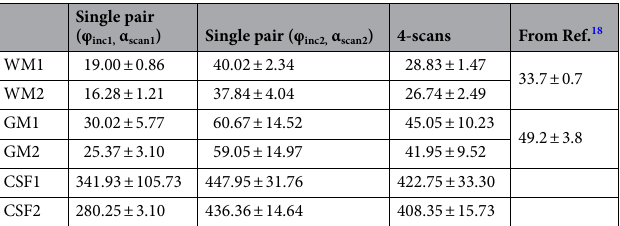
Single pair (φ inc1, α scan1